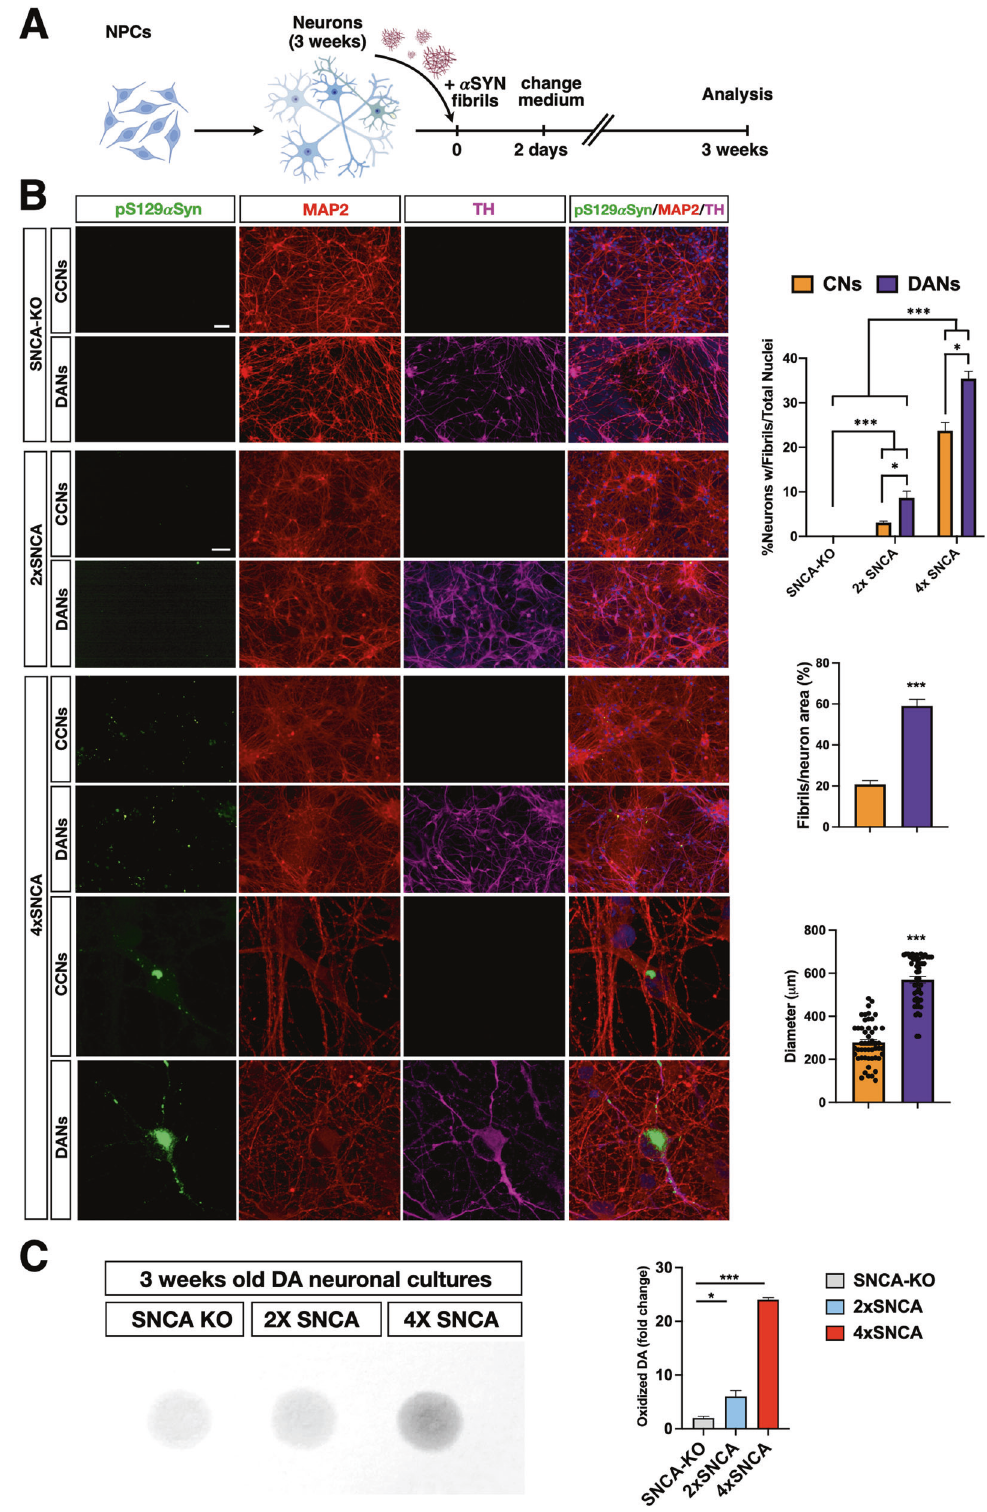
the new set of isogenic iPSCs generated in this study signi fi cantly expands the number of iPSC lines available for this important PD- causing genetic alteration and provides for the fi rst time a full panel of isogenic cells that differ for only the incremental number of SNCA genes. Generating iPSCs from more individuals with SNCA